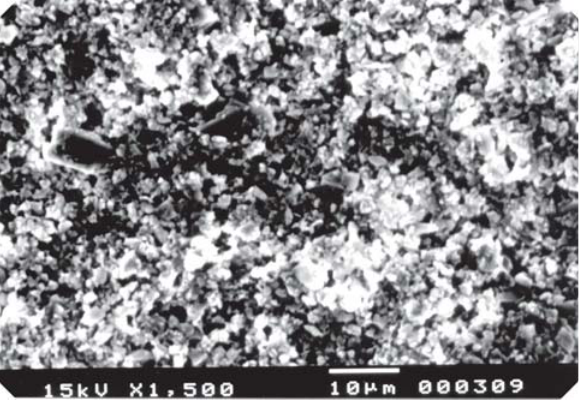
FIGURE 2- Abrasive particles of Dentu-Creme